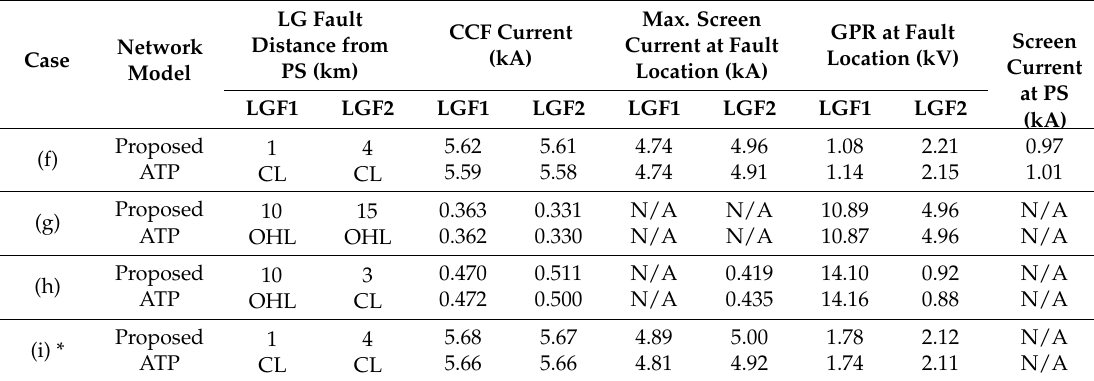
Table 3. Simulation results for CCFs occurring in the same 20 kV